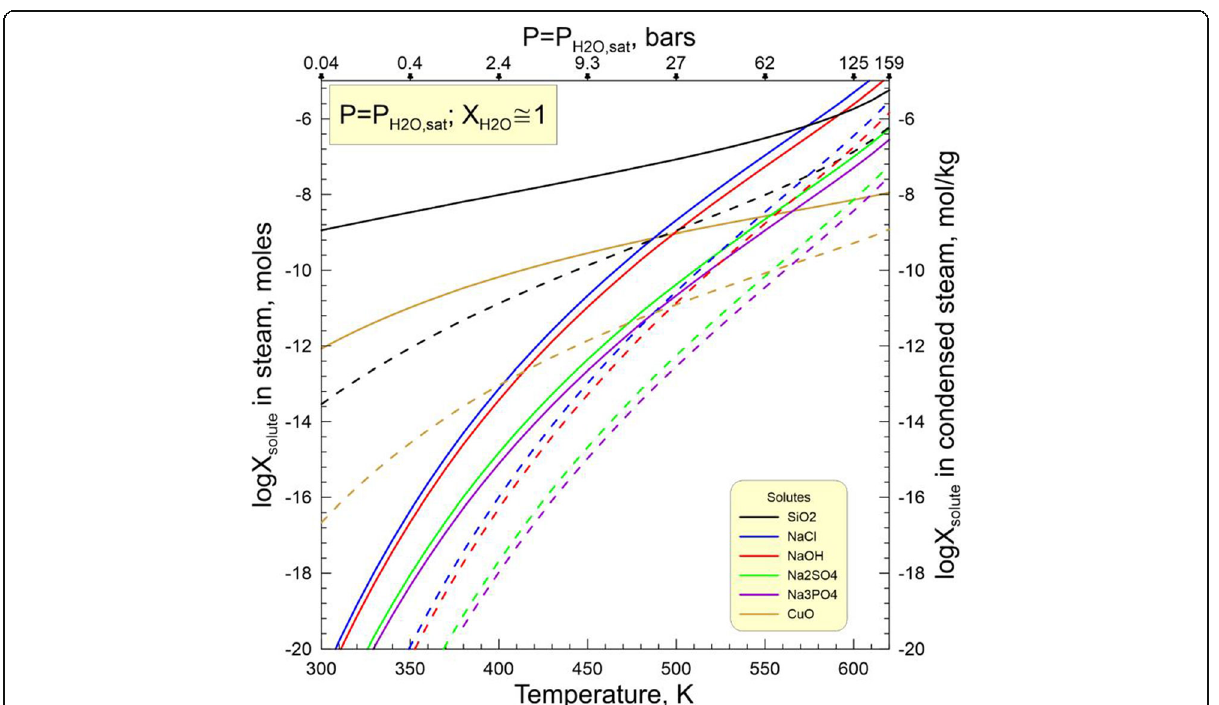
Fig. 15 Maximium solubility of different solutes in the saturated H 2 O steam (solid lines) and the aqueous solution formed by its condensation (dashed